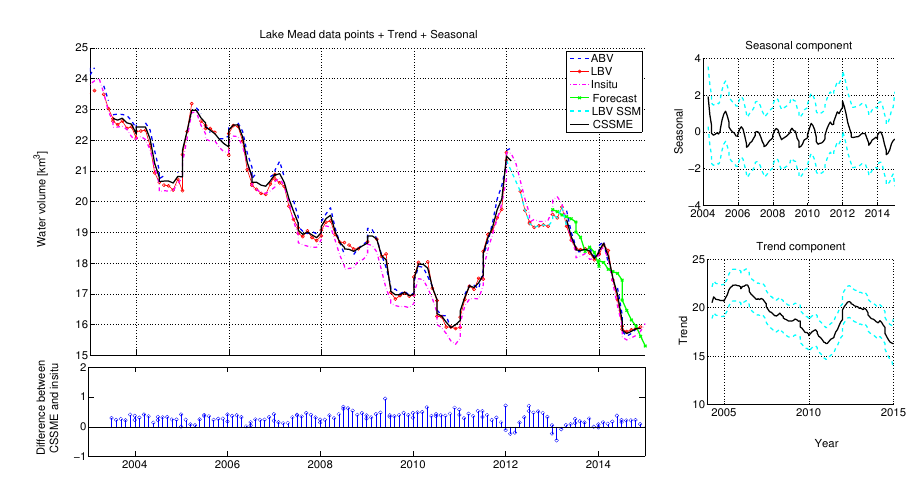
Figure 2. Lake Mead SSM analysis. ( Top left ) The combined SSM estimate (CSSME) (black line) and the forecast (green line) for 2013 and 2014; ( Bottom left ) difference between CSSME and in situ observations; ( Top right ) estimated seasonal component; ( Bottom right ) estimated trend component. The dashed cyan lines indicate the upper and lower 95% confidence limit.